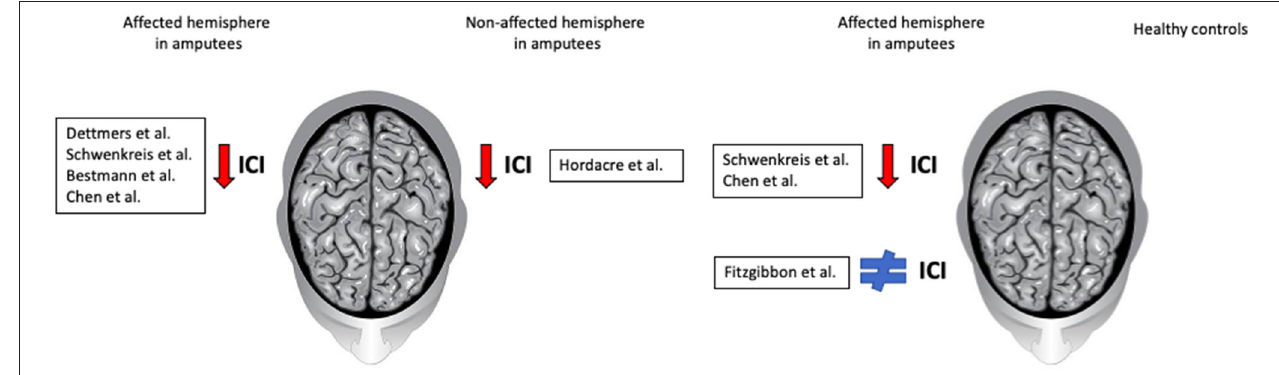
FIGURE 1 | Summary results and comparisons of intracortical inhibition. The first panel shows comparisons between affected and non-affected hemisphere in amputees; most authors reported a decreased SICI in the affected hemisphere. The second panel shows the comparison between amputees and healthy subjects; while some authors report a decreased SICI in the affected hemisphere of amputees, others found no